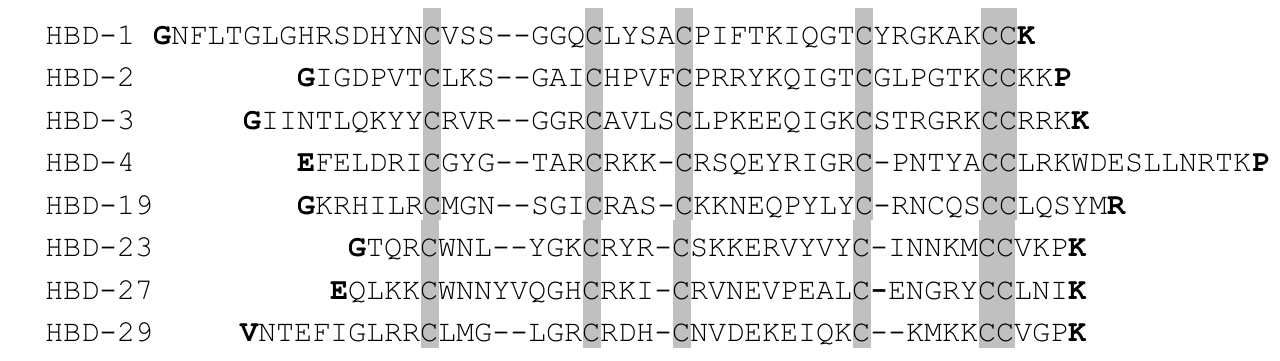
Figure 1. Sequences of known and predicted human  -defensins. The known sequences of HBD-1, 2, 3 and 4 are aligned with the predicted sequences of HBD-19, 23, 27 and 29. The sequences shown. Gaps were introduced to align cysteine residues, which are shaded.